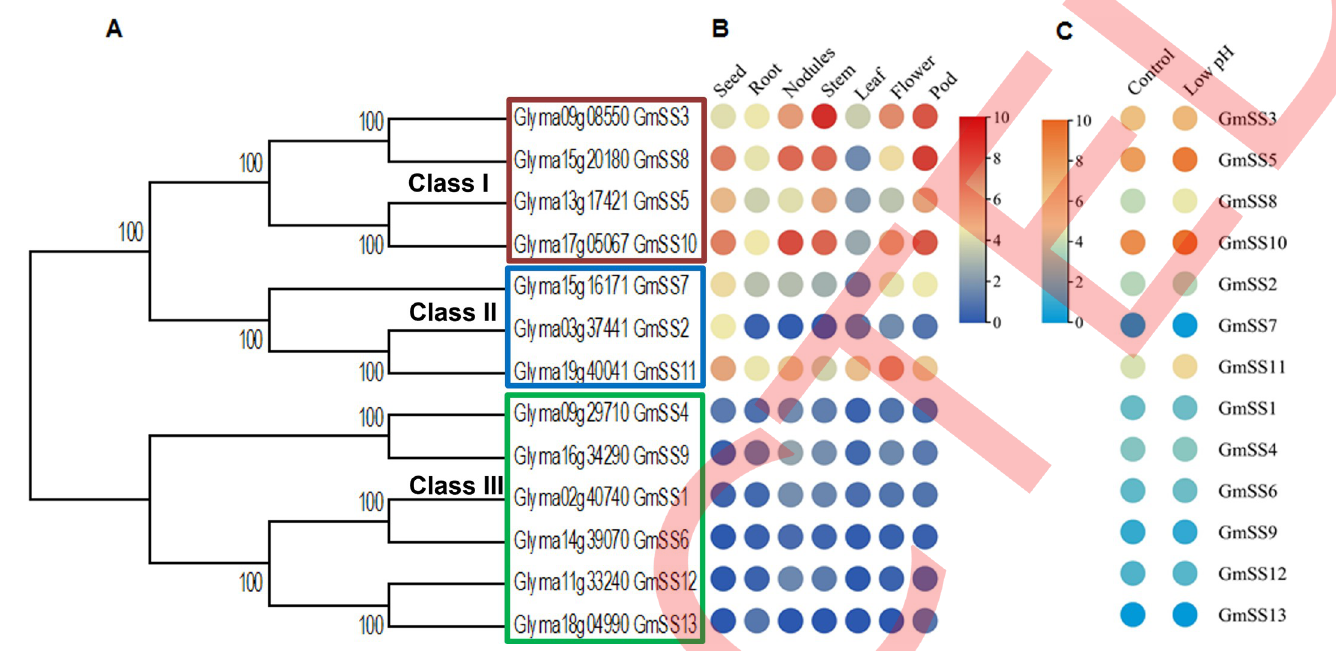
Fig 8. Phylogenetic analyses, tissue specific and response to low pH (4.0) expression of GmSS genes. (A) Phylogenetic tree and nomination of all soybean SS genes (13 in total). The genes are listed according to the chromosomal arrangement, and different classes are highlighted in different colors: Class I in maroon, Class II in blue, and Class III in green. (B) The heat map of 13 GmSS genes expression in different tissues was constructed using TBTool software by average linkage with Euclidean distance. Color key represents the relative transcript abundance of the GmSS genes in seven soybean tissues. The FPKM values were log2 transformed and mean centred by genes using the TBTool software. (C) The expression level of different GmSS genes in response to low pH stress were retrieved from generated Solexa sequencing libraries, analyzed and represented by constructing the heat map using TBTool software.